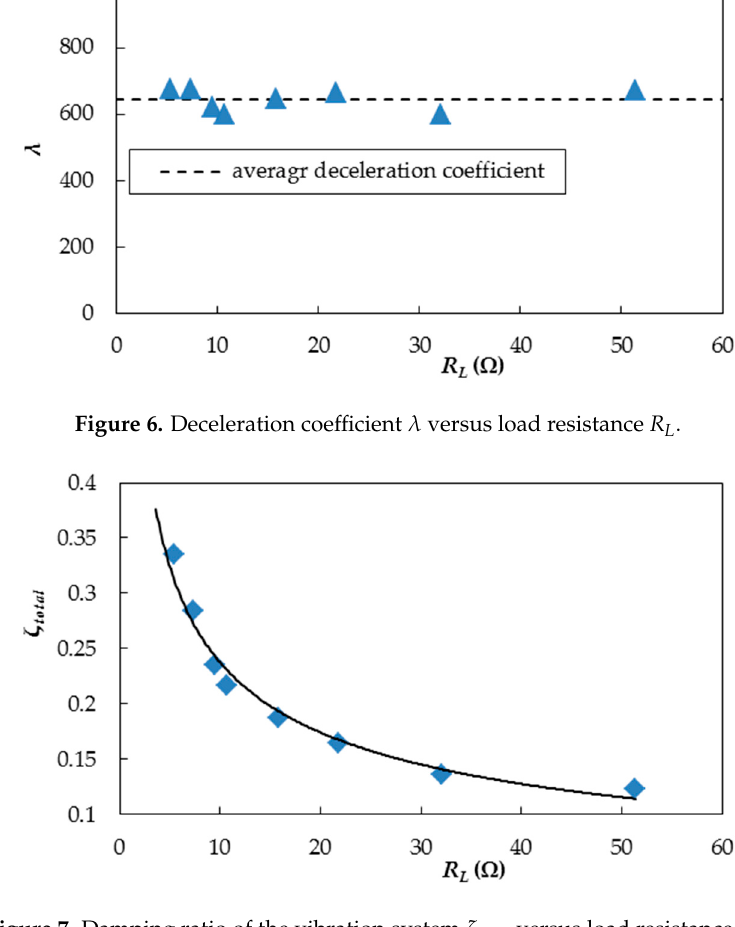
Figure 7. Damping ratio of the vibration system ζ total versus load resistance R L .